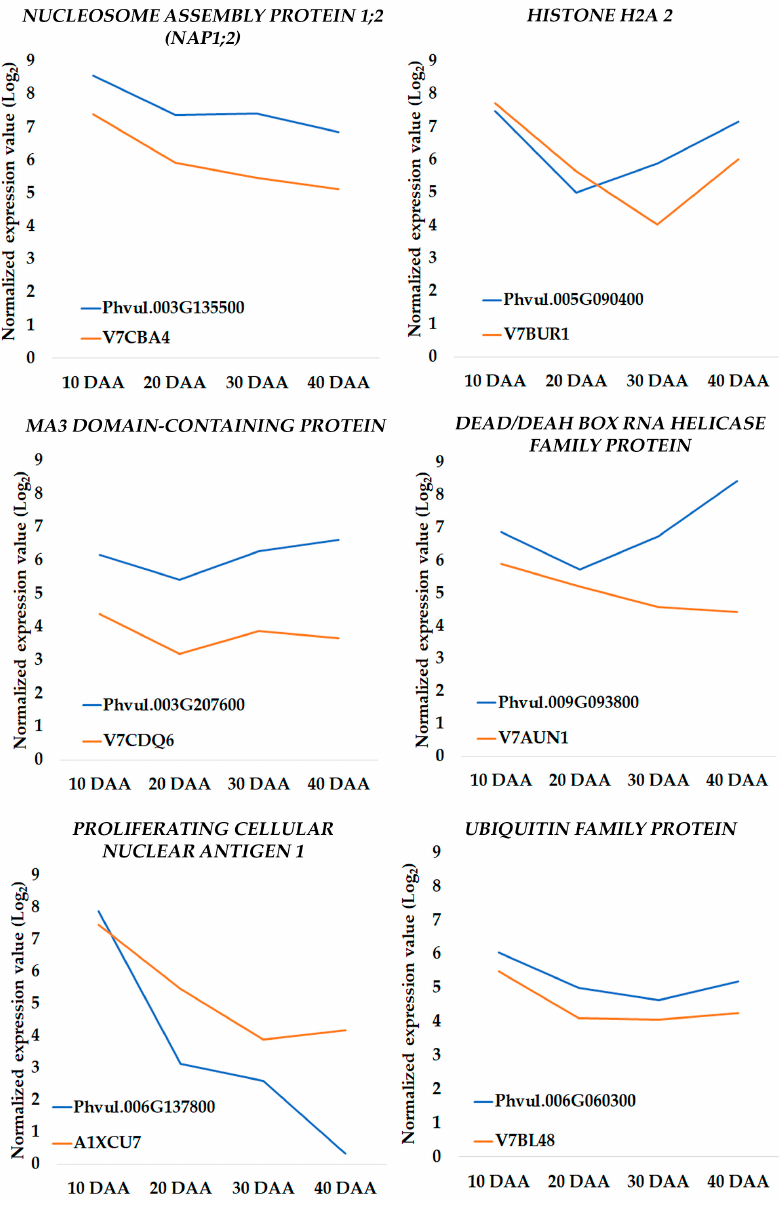
Figure 5. Abundance profiles of proteins [21], and expression of their correspondent genes, related to the DNA metabolism. Line in blue: Log 2 of the normalized expression values of the gene. Line in orange: Log 2 of the average normalized intensity values of the protein.